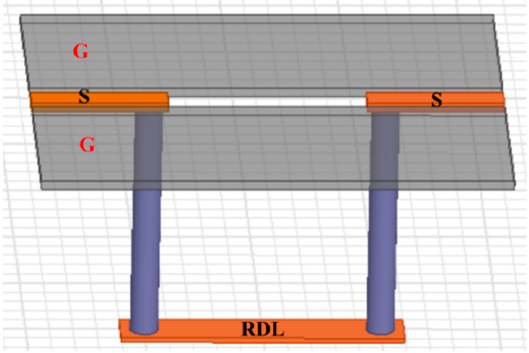
Figure 2. Simulation model of CPW structure in HFSS: Ground-Signal-Ground structure.